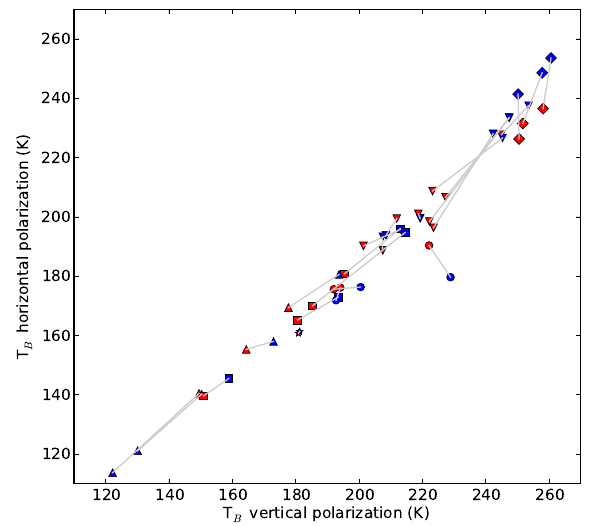
Fig. 11. Brightness temperatures at 55 ◦ incidence angle and 37GHz, at vertical polarization versus horizontal polarization for a variety of sites: Dome C, Antarctica (stars), Arctic tundra (trian- gles up), Arctic windy tundra (triangles down), Arctic fen (squares), grassland (diamonds), ice-sheet ablation or percolation areas (cir- cles). Observations are in red and DMRT-ML predictions in blue. The gray lines link the observation and prediction of the same site.